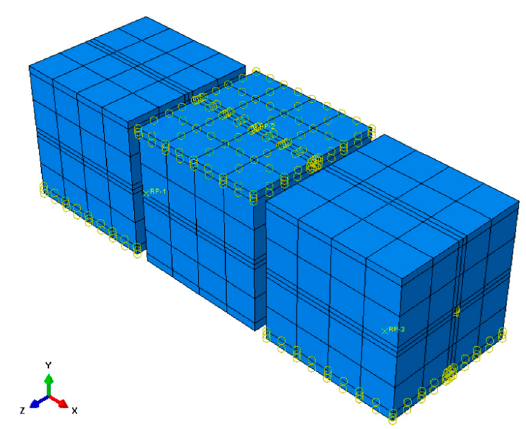
Figure 8. Rigid bodies of the static